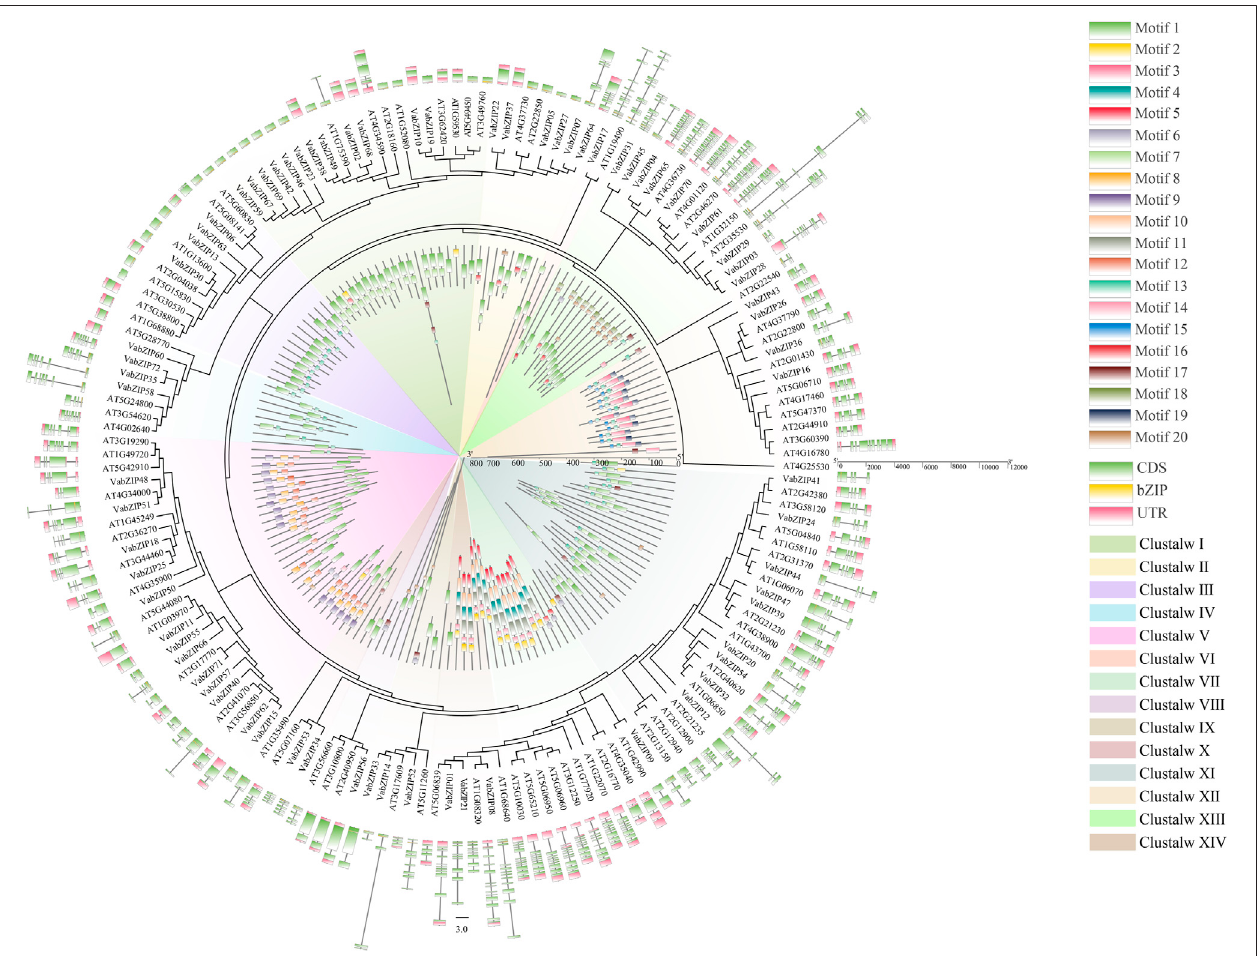
FIGURE4| EvolutionofbZIPmembersin Arabidopsis andVabZIPs.TheinnerringindicatesthemotifsofbZIPmemberswhiletheouterringisthegenestructureof bZIP members.